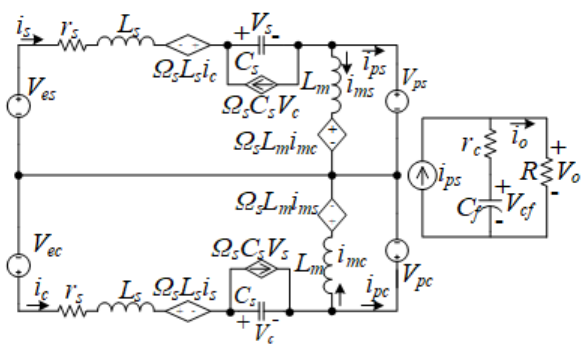
Figure 9. Small signal equivalent